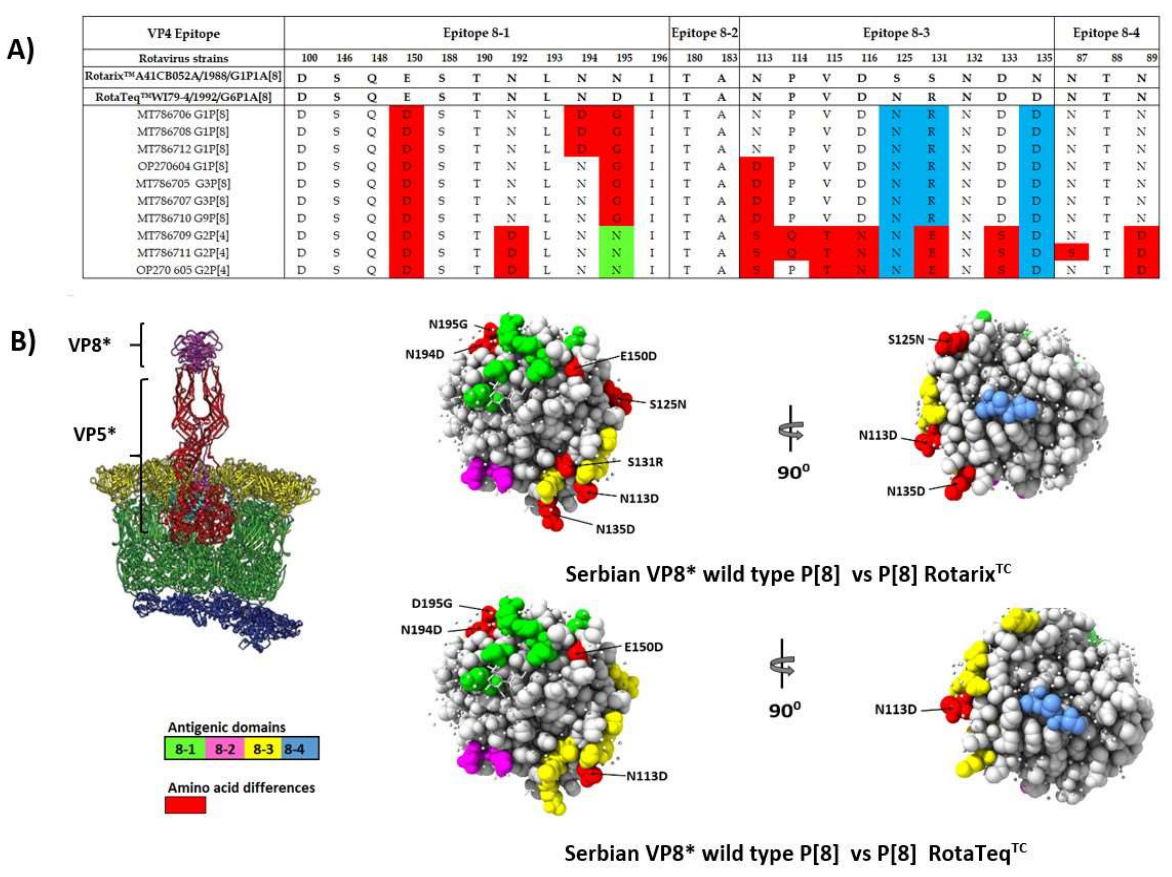
Figure 5. ( A ) Alignment of antigenic epitopes of the VP4 rotavirus strains circulating in Vojvodina, Serbia, with those of the Rotarix™ and RotaTeq™ vaccines. Alignment of the amino acid residues defining the neutralization domains of the VP4 protein (8-1, 8-2, 8-3, and 8-4) of rotavirus strains analyzed. ( B ) Surface representation of the globular domain VP8* of VP4 protein (Protein Data Bank (PDB) accession 1KQR). Antigenic epitopes 8-1, 8-2, 8-3, and 8-4 are marked in green, purple, yellow, and blue colors, respectively. Red color shows surface exposed residues which differ between our and vaccines strains.